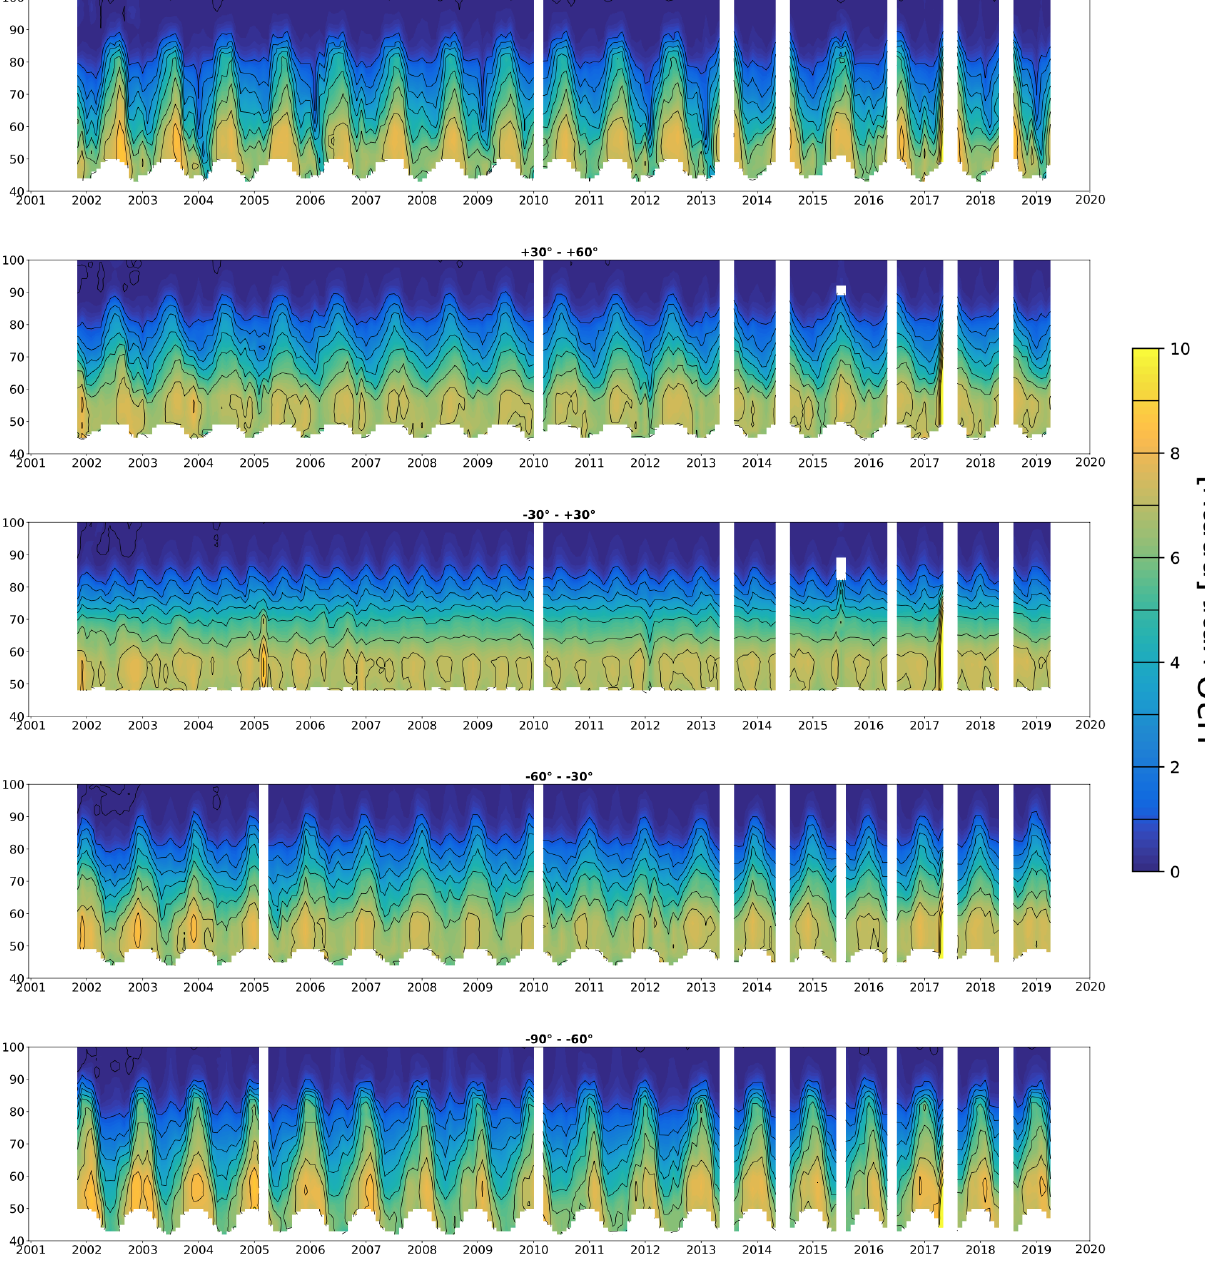
Figure 4. Time series of FM19 H 2 O volume mixing ratios measured by SMR for different latitude bands. The white areas indicate periods and altitudes at which the number of measurements in the given latitude band is lower than 10. The ticks on the x axis correspond to the beginning of each